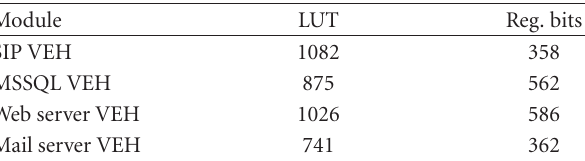
Table 3: Synthesis results for the